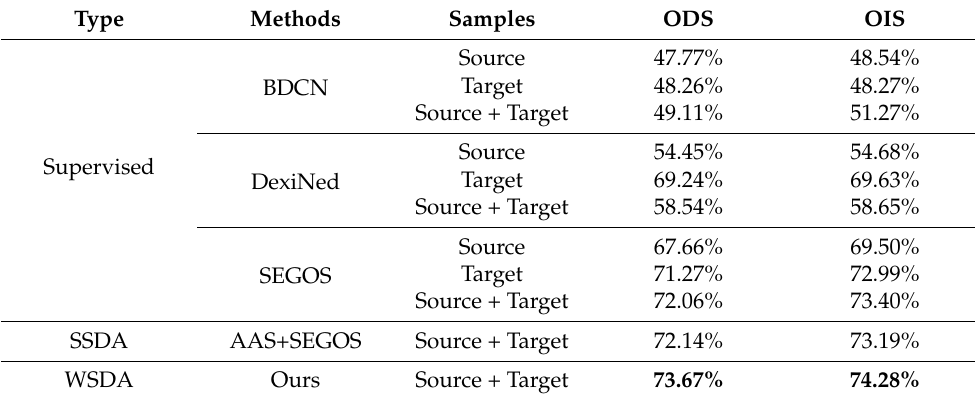
Table 3. Accuracy comparison among different edge detection